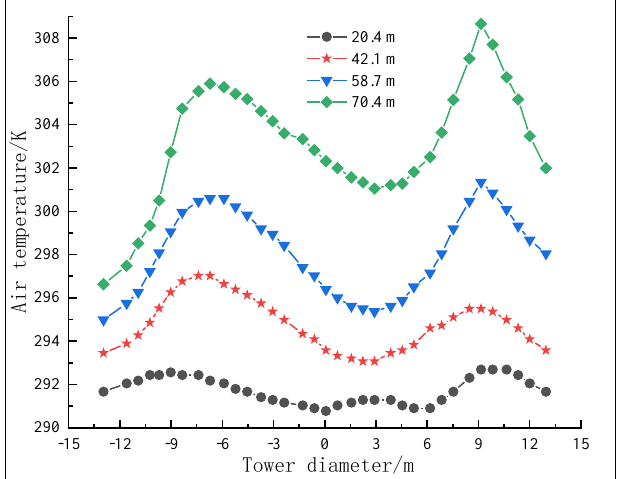
Figure 7. Radial distribution diagram of temperature at cross section of granulation tower.